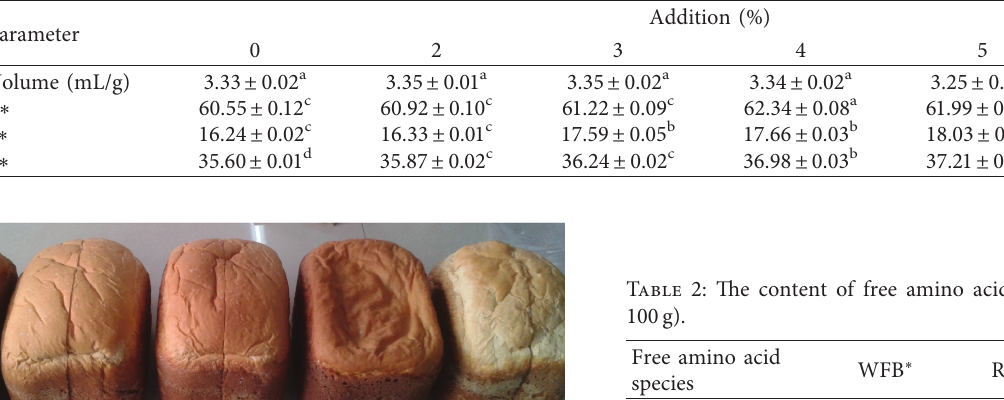
Table 1: The comparison of specific volume and color of breads with different adding proportion.